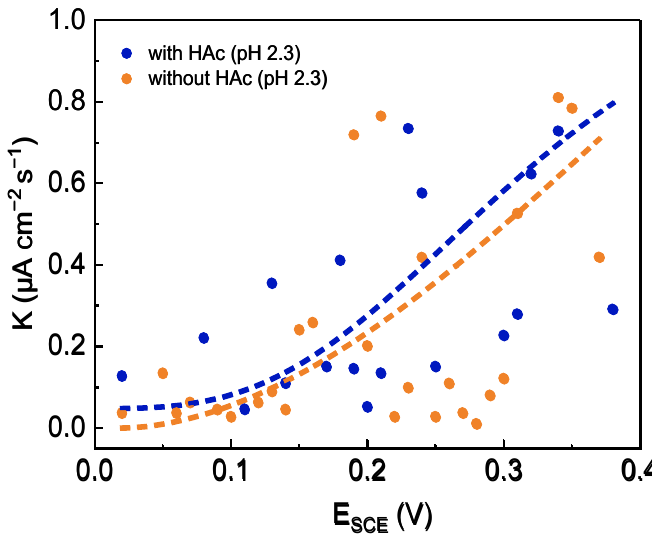
Figure 10. Comparison of the growth rate of metastable pits of 304 SS in 0.6 mol/L NaCl solutions (pH 2.3), both without and with 0.8 mol/L HAc. (pH 2.3), both without and with 0.8 mol/L